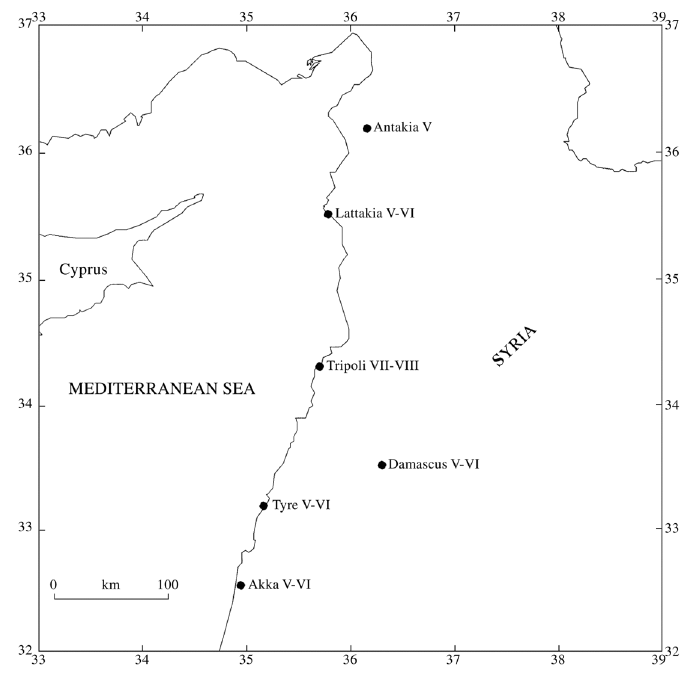
Fig. 7. Map of intensity distribution for July-August, 1063